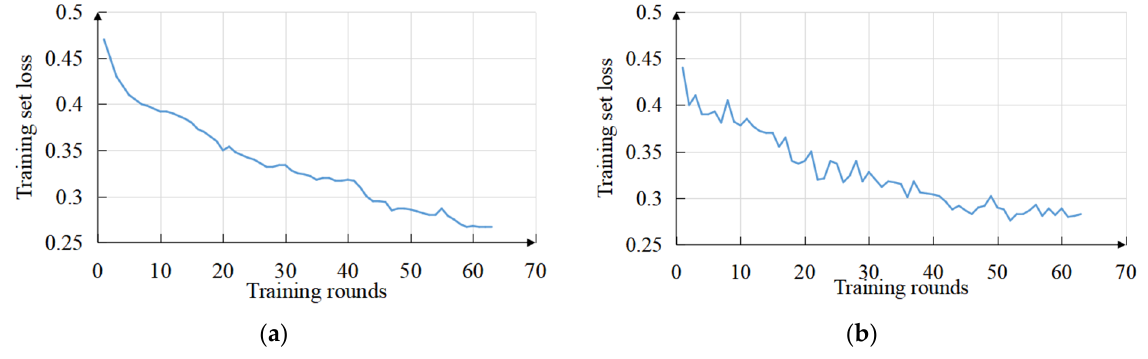
Figure 12. Loss function curve. ( a ) Training set loss. ( b ) Validation set loss.